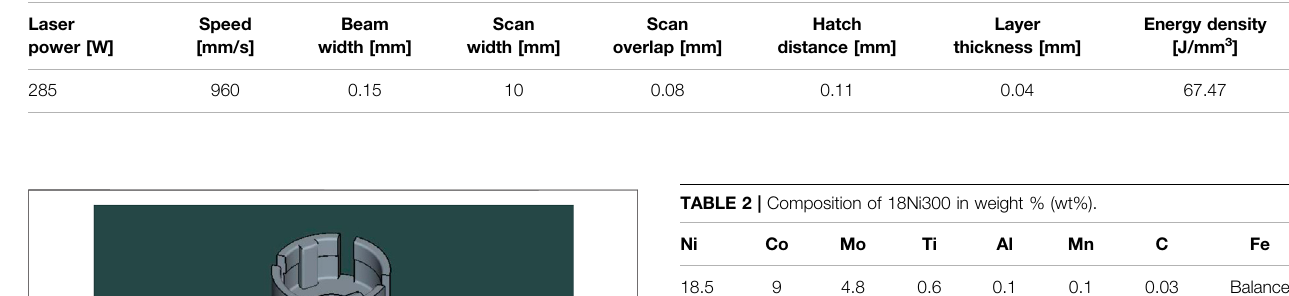
TABLE 1 | Recommended printing parameters for 18Ni300 (Yakout, 2017; Yin et al., 2018; Shamsdini et al., 2020) .